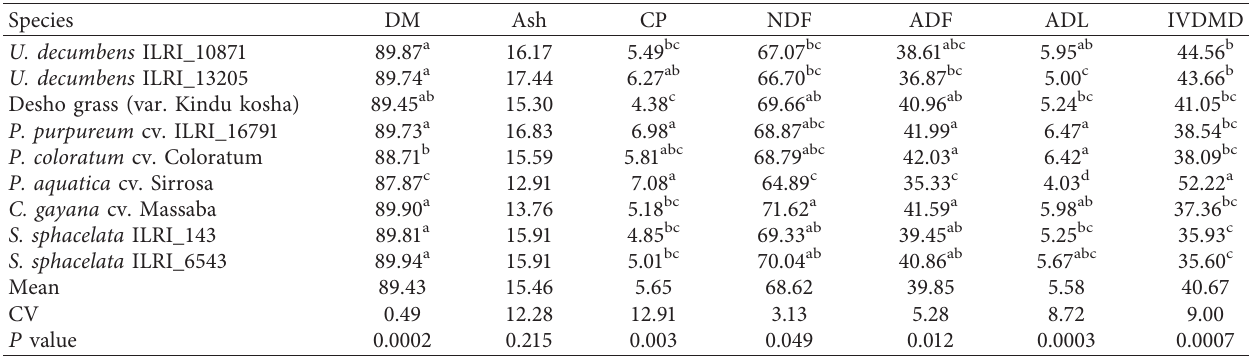
Table 9: Nutrient content of perennial forage grass species evaluated under supplementary irrigation at Holetta. Species DM